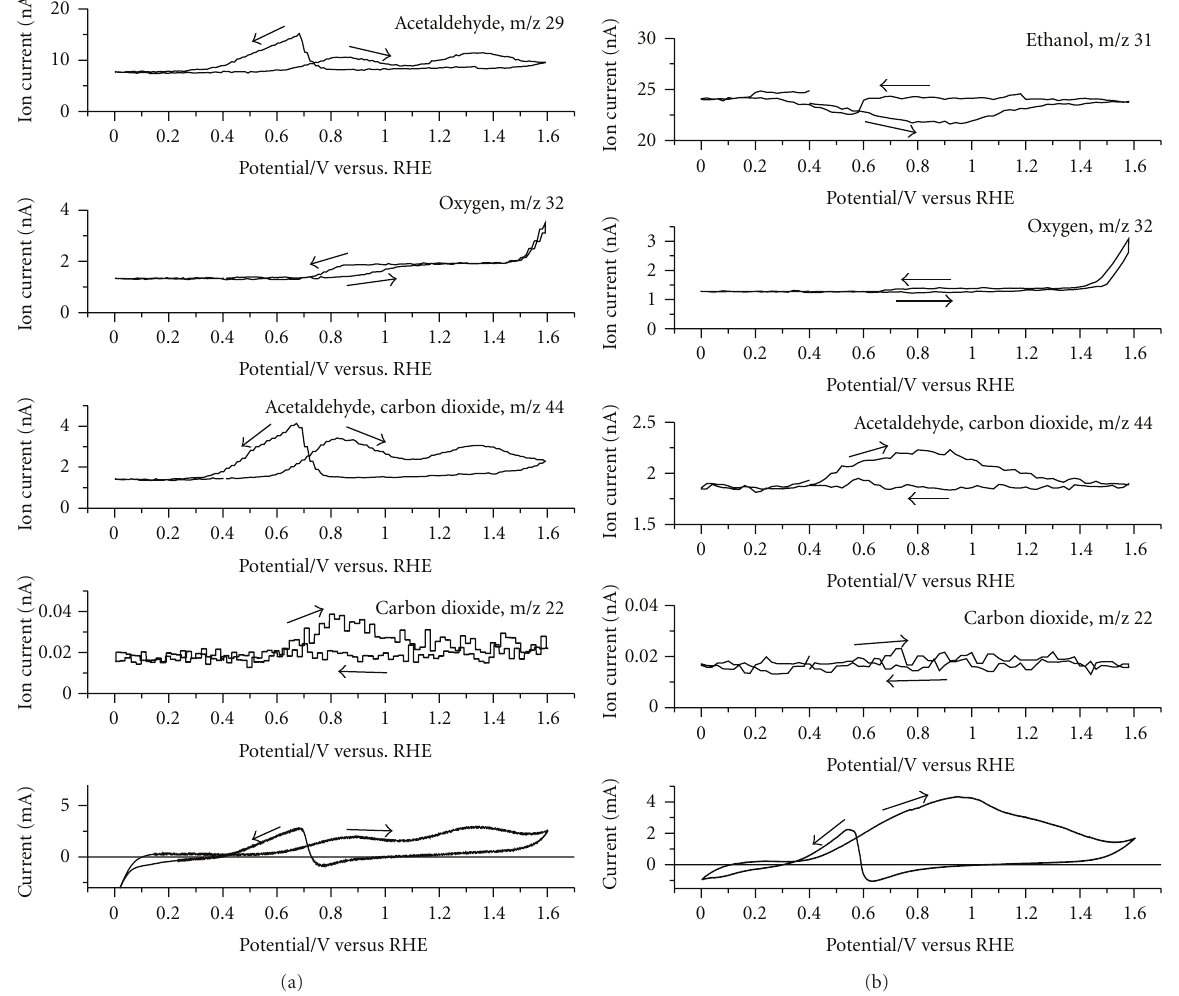
Figure 4: Mass spectrometric cyclic voltammograms (MSCVs) of 1wt.-% ETBE in 0.5M H 2 SO 4 (a) and 0.1 M KOH (b). Mass fragments and assignment of substances as indicated in the graphs. Scan rate 10mVs − 1 , flow rate 2.4mLmin − 1 .